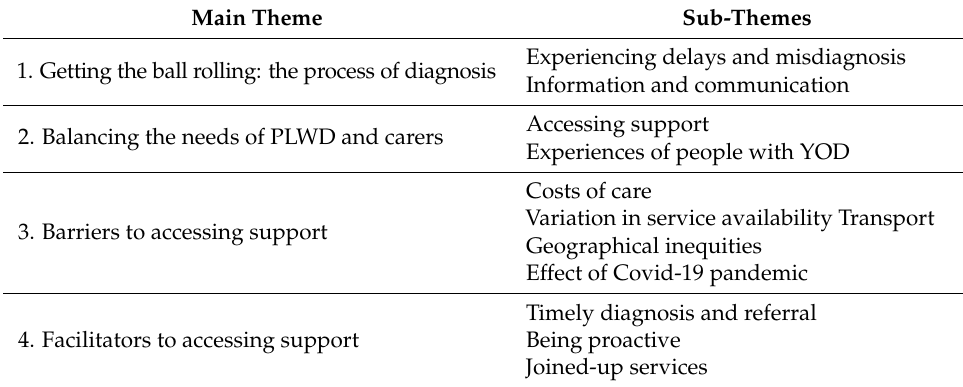
Table 1. Themes from participant